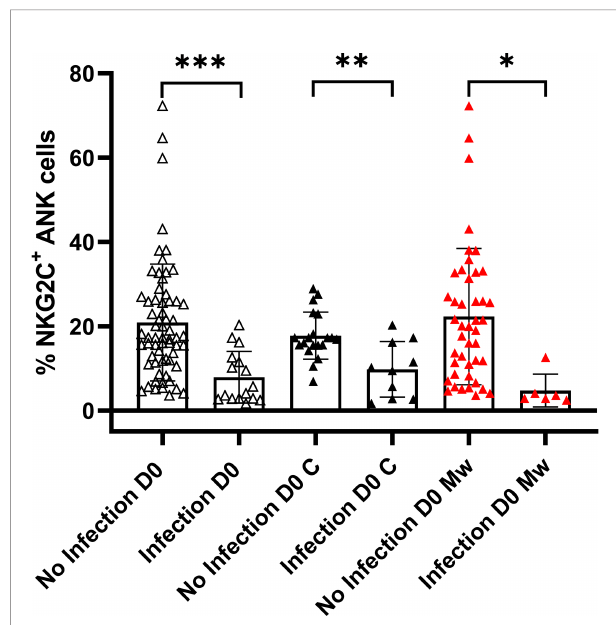
FIGURE 2 | Relationship between NKG2C + ANK cells and COVID-19: Scatter dot with bar plot showing expression of NKG2C + ANK cells at baseline in the overall cohort (no infection, n=64 and infection, n=16), control group (no infection, n=20 and infection, n=10) and Mw group (no infection, n=44 and infection, n=6) with respect to SARS-CoV-2 infection. Black and red upside shaded triangles represent NKG2C + ANK for Control group and Mw group respectively and unshaded upside triangles represent NKG2C + ANK of both groups combined. ***p < 0.001, **p < 0.01 and *P < 0.05.